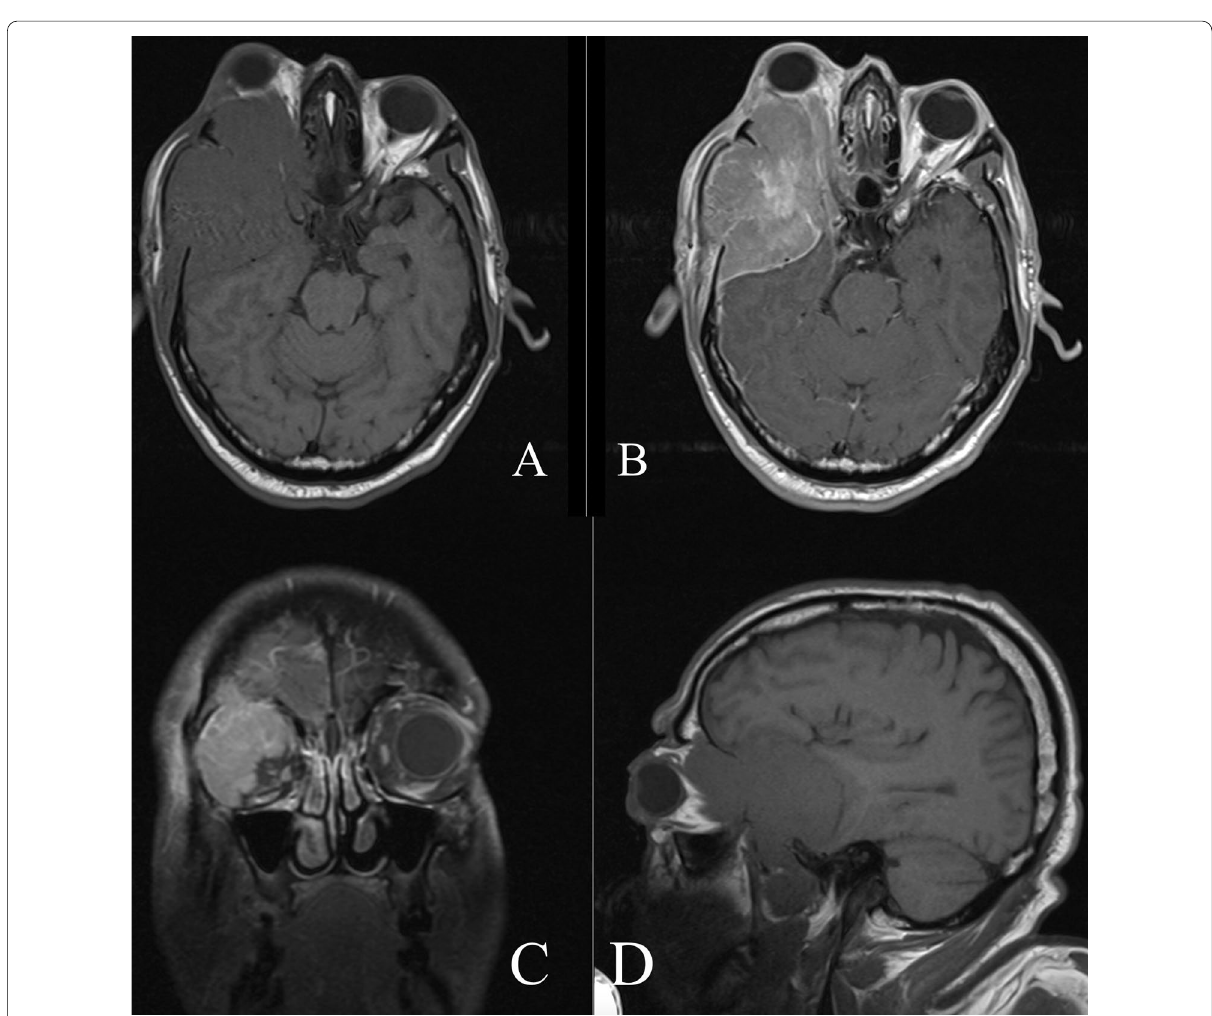
Fig. 2 Preoperative MRI brain. Top row—T1 weighted axial MRI sequences, pre ( A ) and post ( B ) gadolinium, showing degree of invasion into orbit, but lack of intra‑axial spread. Evidence of a dural tail is noted on the post‑contrast sequence. Bottom row—T2 coronal ( C ) and T1 sagittal ( D ) images further highlighting degree of orbital invasion by